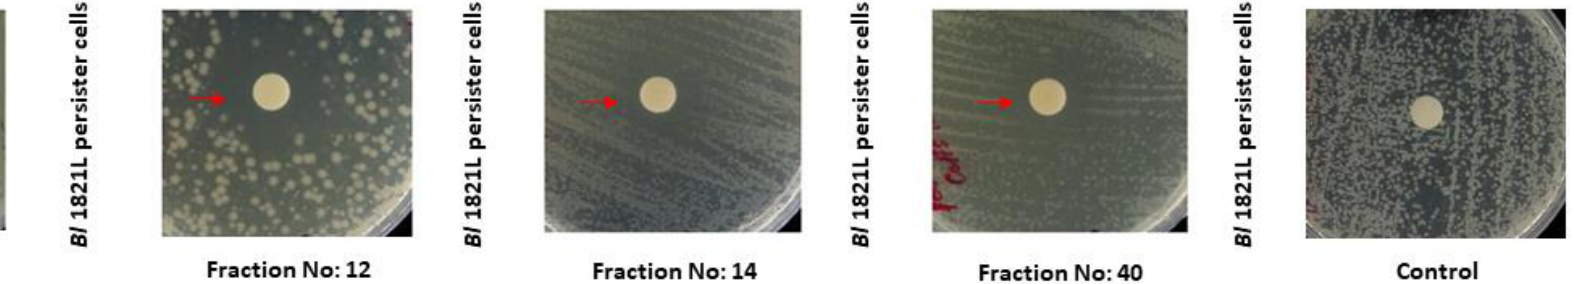
Figure 3. Disc diffusion assay test of Bl 1951 mitomycin C-induced CFS against Bl 1821L persister cells. The red arrow denotes the zone of inhibition due to the activity of mitomycin C-induced CFS against the Bl 1821L persister cells.